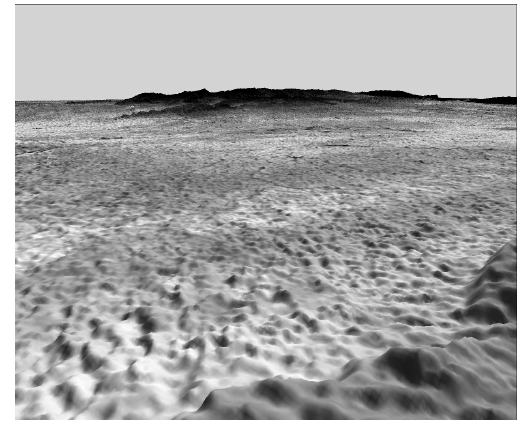
Figure 8. A perspective view over the western piedmont built from Landsat-5 TM image using Image Drape with Erdas Imagine and ASTER DEM. Constructed by M. Törmä